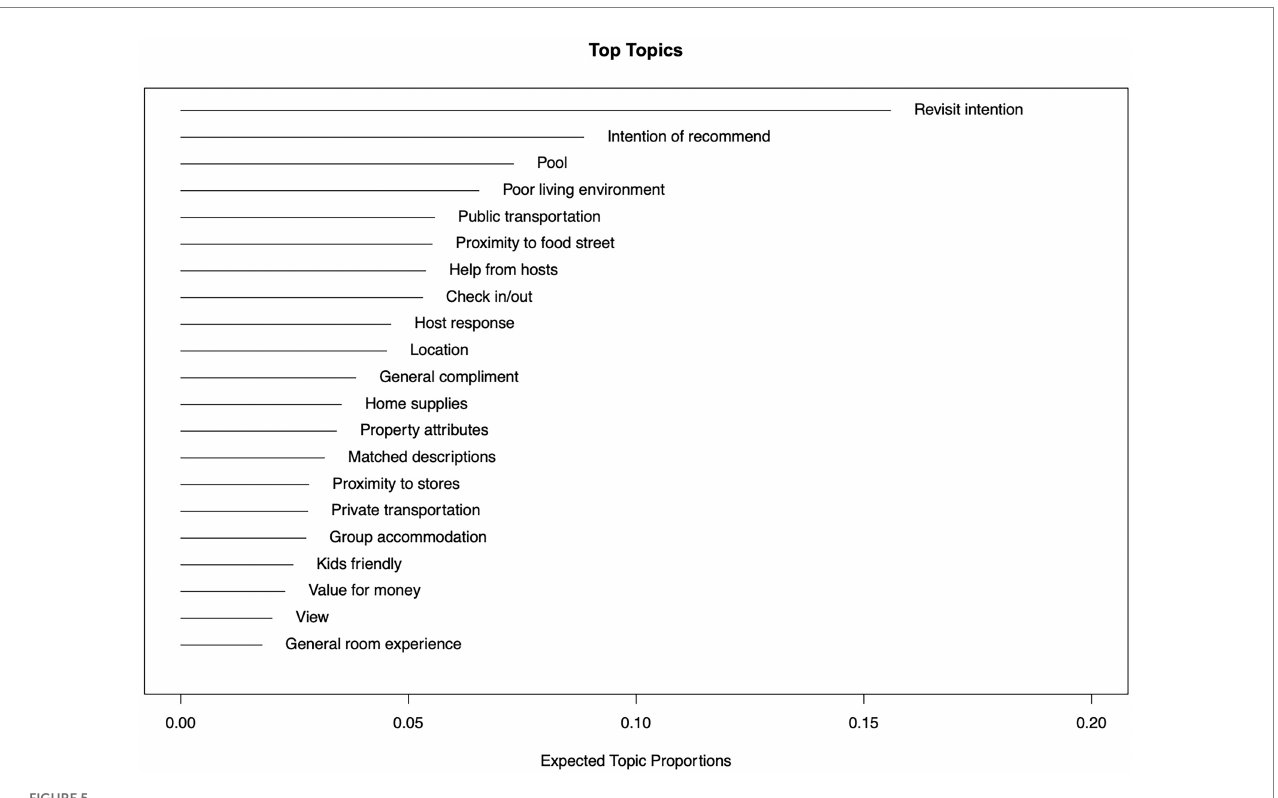
FIGURE 5 Ranking of topics by